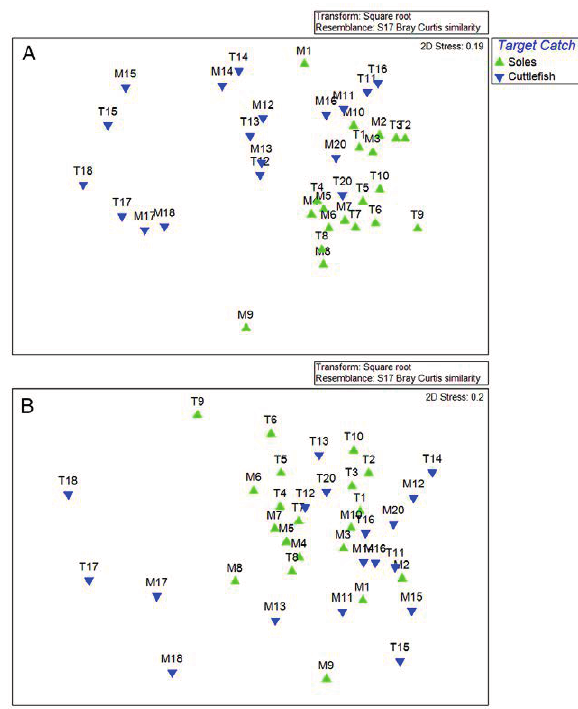
Fig. 5. – MDS plot (square root transformed data) of the abun- dance (A) and biomass (B) of discarded species caught in 19 trips with the two types of net, with the target species (sole or cuttlefish) as factor.